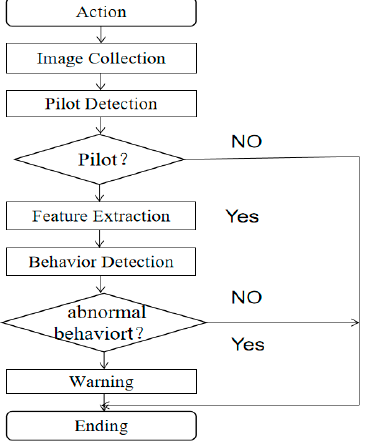
Figure 2. Abnormal behavior detection process .